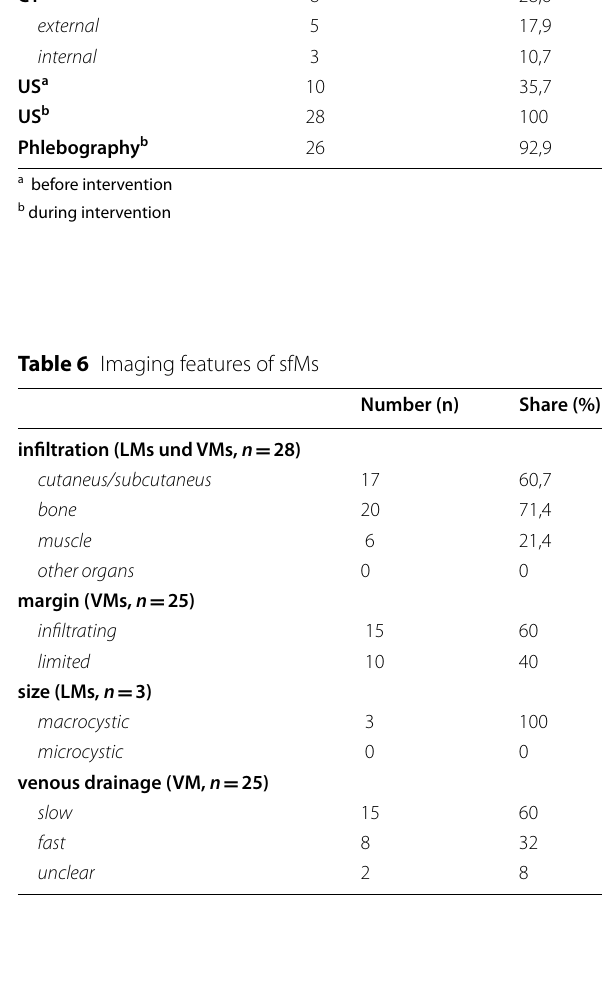
Table 4 ISSVA Classification of vascular tumors